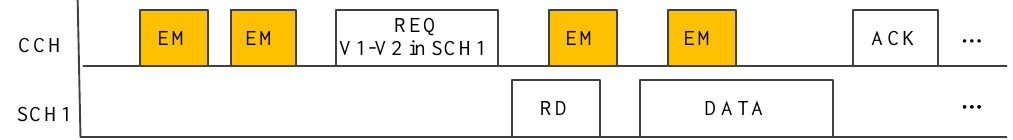
Figure 14. Time structure of PCS-AMMAC.